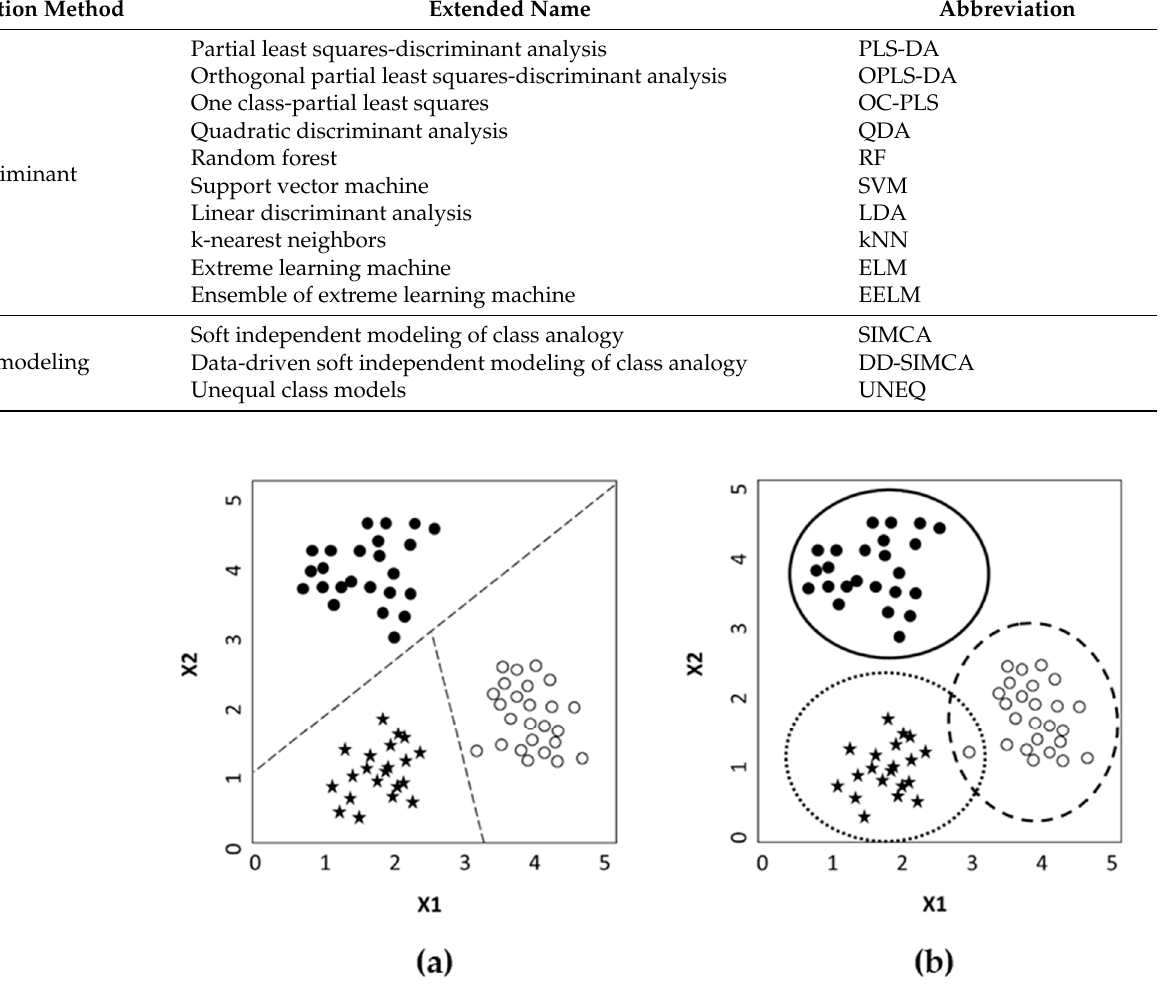
Figure 1. Example of difference between discriminant ( a ) modeling and ( b ) classification methods. In ( a ) the hyperspace is divided into regions equal to the category number.